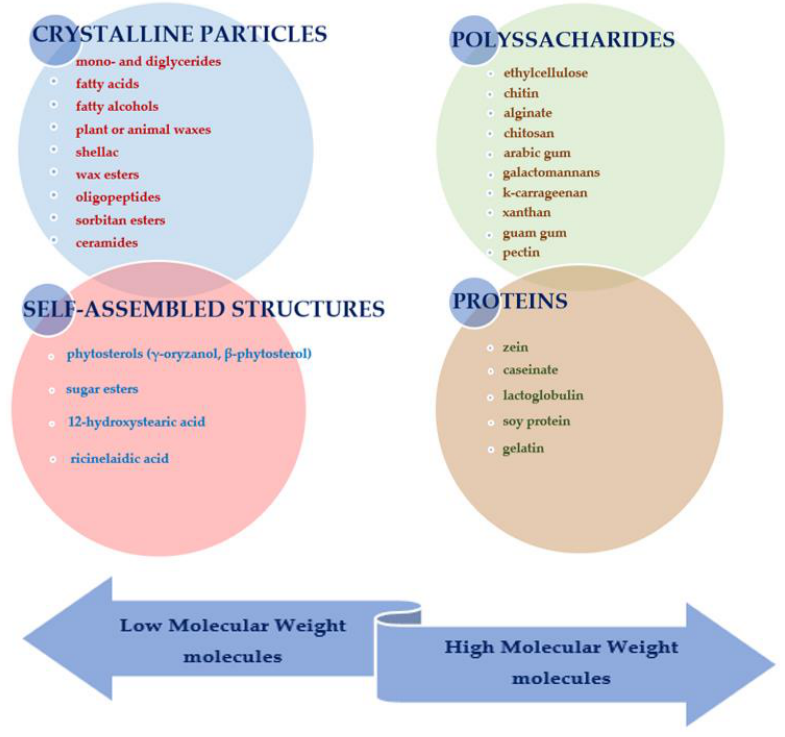
Figure 2. Classification of oleogelators.